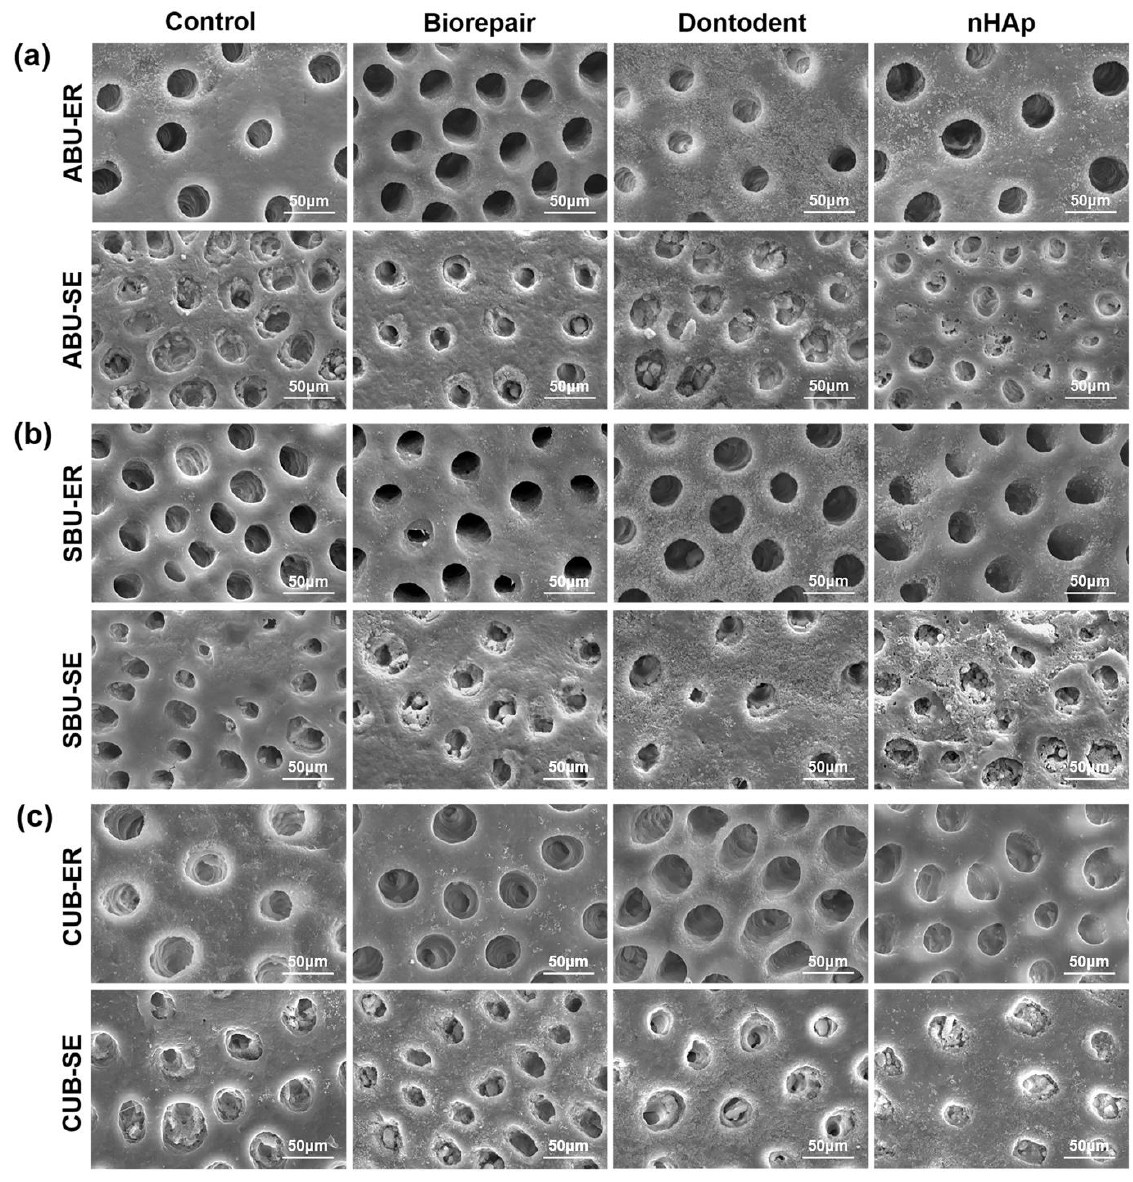
Figure 5. Morphological SEM images of desensitized dentin surfaces treated by universal adhesives with etch-and-rinse mode or self-etch mode. ( a ) All-Bond Universal (ABU). ( b ) Single Bond Universal (SBU). ( c ) Clearfil Universal Bond (CUB). ER: etch-and-rinse mode; SE: self-etch mode.